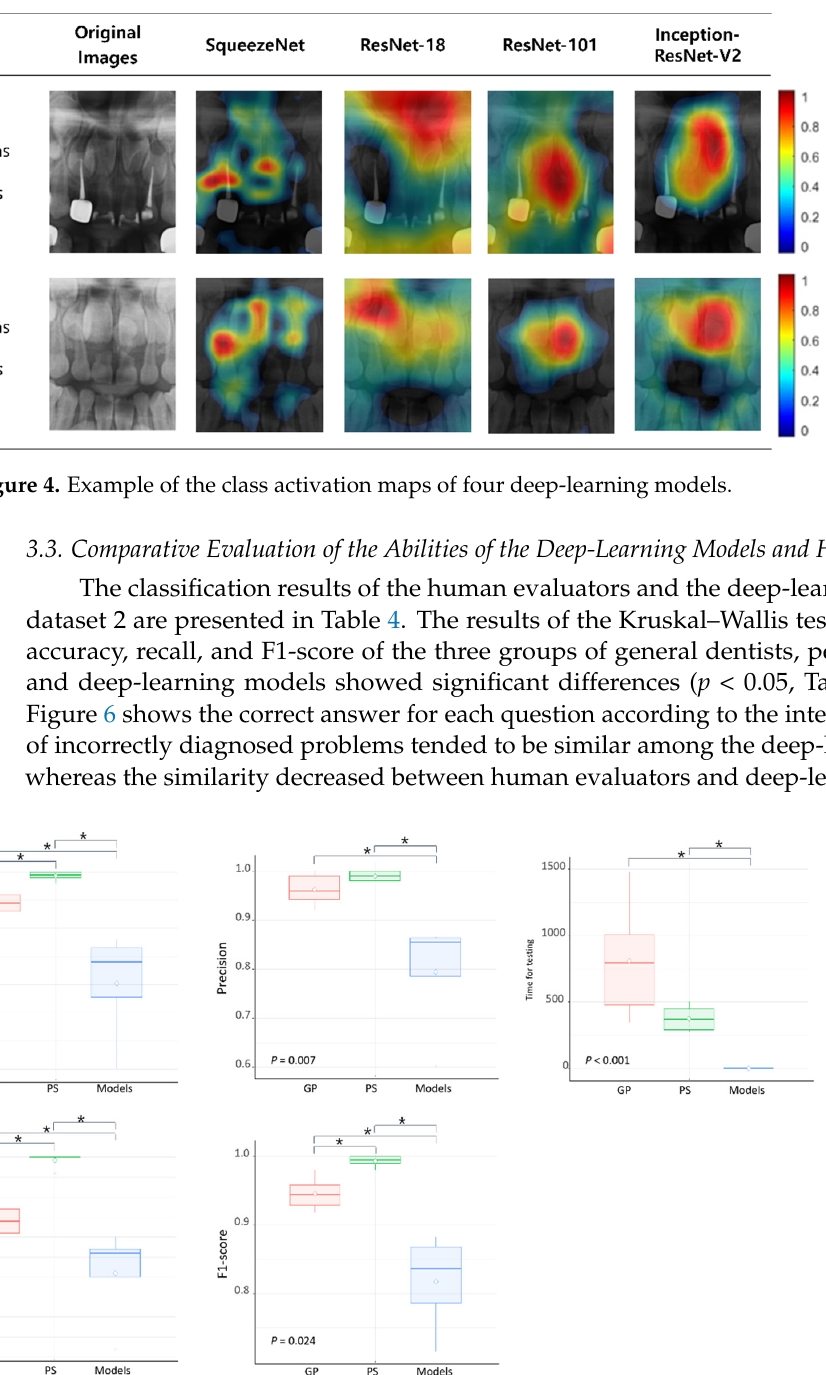
Figure 5. Boxplot of diagnostic performances among three groups. Kruskal–Wallis test was performed to analyze the statistical significance of specificity. GP: General Practitioners, PS: Pediatric Specialists, * p < 0.05; Kruskal–Wallis test.